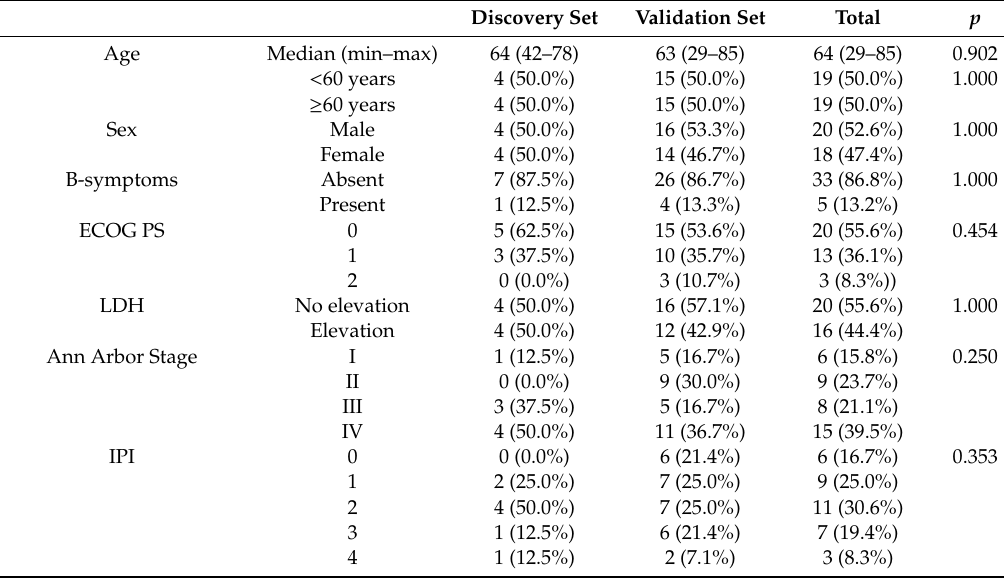
Table 1. Clinicopathological features of study